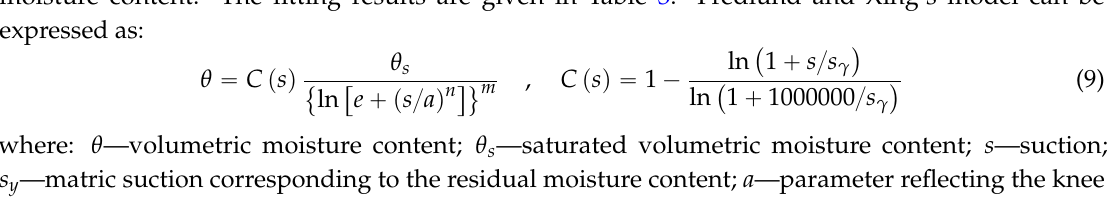
Table 3. Fitting results of soil water characteristic curve. Material